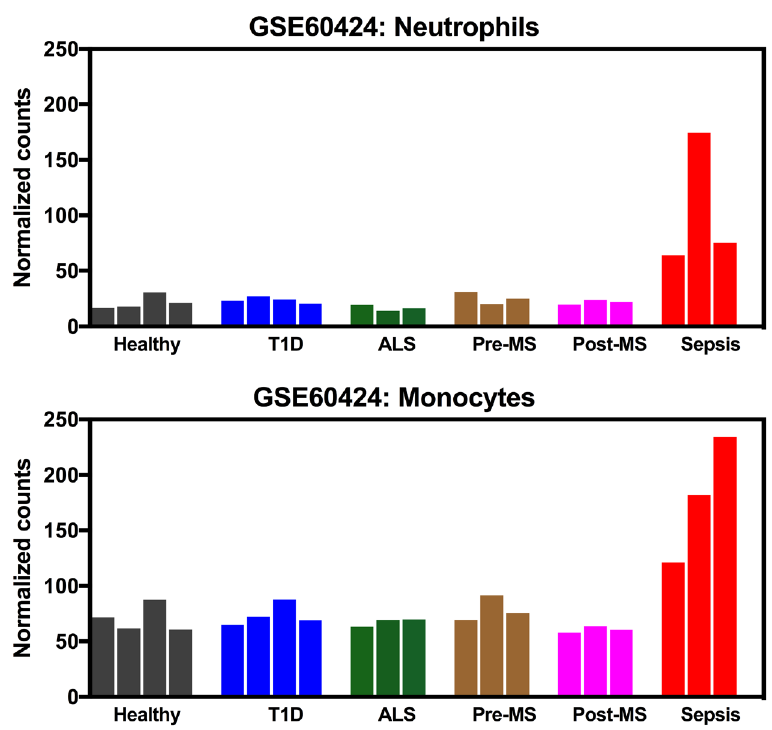
Figure 1. Elevated abundance of ADAM9 transcript in human monocytes and neutrophils during sepsis. The bar graphs show the abundance of ADAM9 transcripts measured by RNA-seq in neutrophils (top) and monocytes (bottom) isolated from blood collected in healthy donors (Black), patients with Type 1 diabetes (Blue), patients with ALS (Green), patients with multiple sclerosis pre- (Pre-MS; Brown) and post- (Post-MS; Pink) interferon treatment and patients with acute infections (sepsis; Red, caused by Clostridium difficile , E. coli and Meningococcal bacteria,